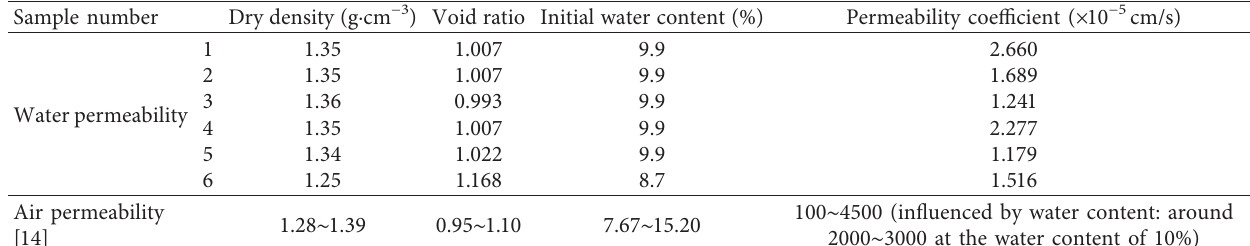
Table 4: The loess sample permeability test